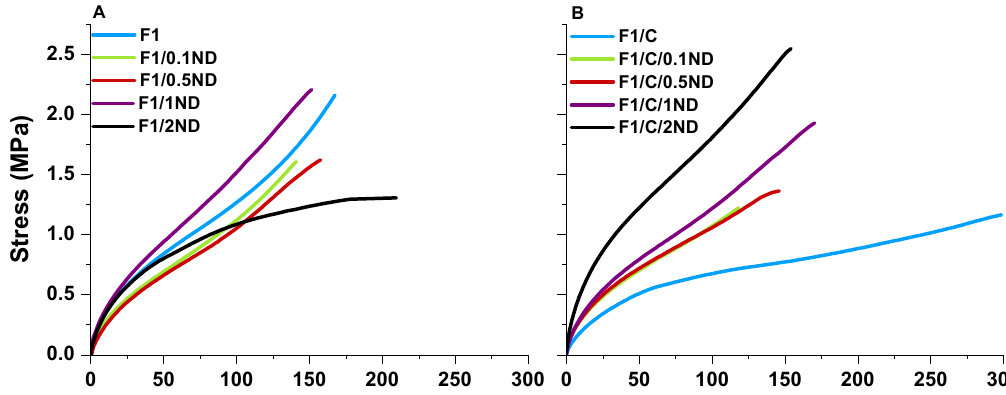
Figure 2. Mechanical properties of films with different ND filler contents. ( A ) Young’s modulus, ( B ) strain at break, ( C ) stress at break, and ( D ) toughness.